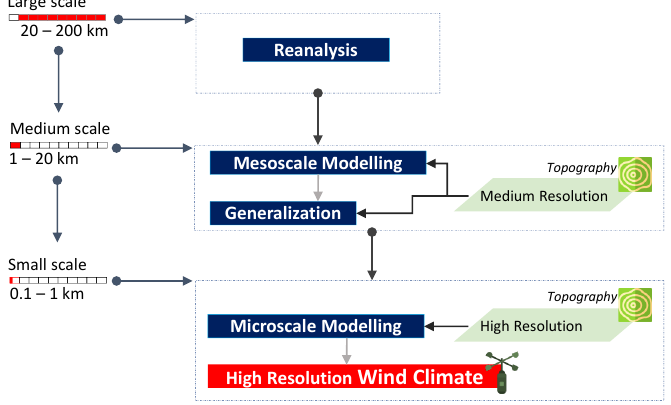
Figure 7. Downscale process. Own elaboration.